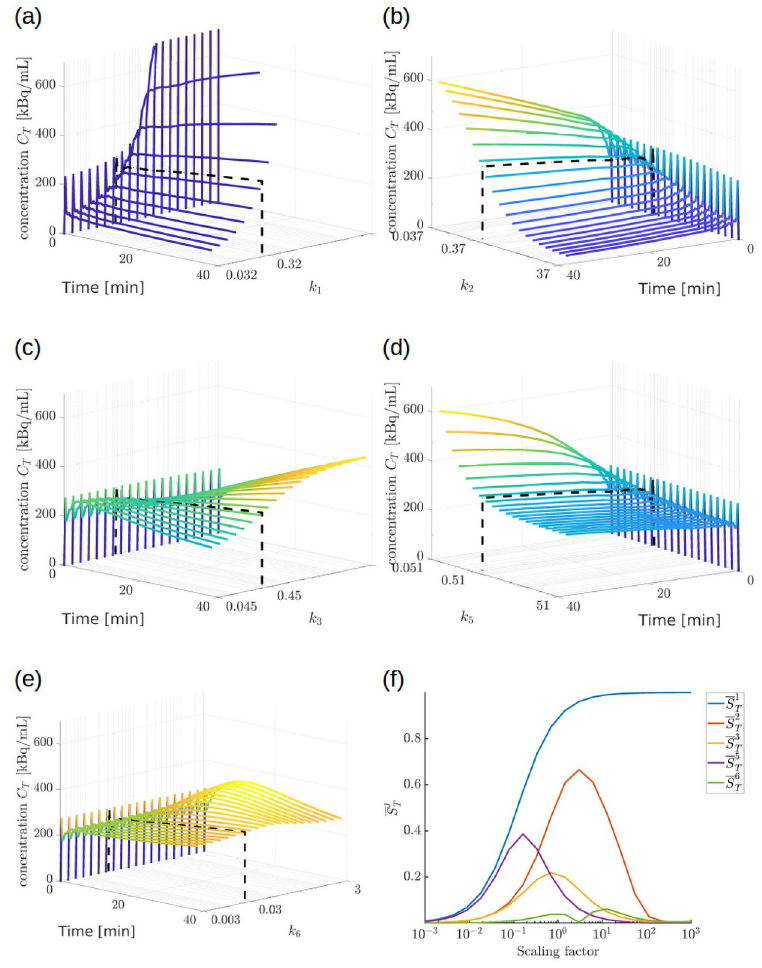
Fig 3. Sensitivity analysis for the five kinetic parameters utilized in BCM. (a)-(e) Behaviour of the total concentration C ð t Þ computed using Eqs (5) and (16) for several values of the kinetic parameters. Each panel refers to a T different parameter k j . Specifically, the black dotted curve has been computed by using the values of the parameters provided by solving the compartmental inverse problem for mouse m1. The other curves have been obtained by modifying only the parameter k j . Notice that the axis in the different panels present different orientations so as to improve the visibility of the plotted curves. (f) Asymptotic value � S j of S j in Eq (26) for t = 40 min. Each curve depicts T T the value of � S j for a different kinetic parameter k as function of its normalized value k = ^ k (scaling factor). j T j j